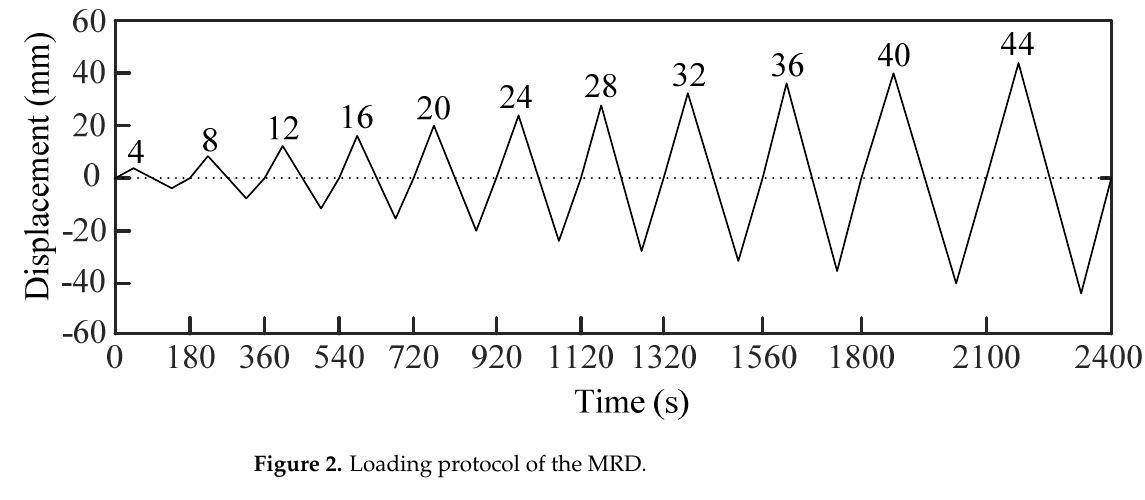
Figure 2. Loading protocol of the MRD.